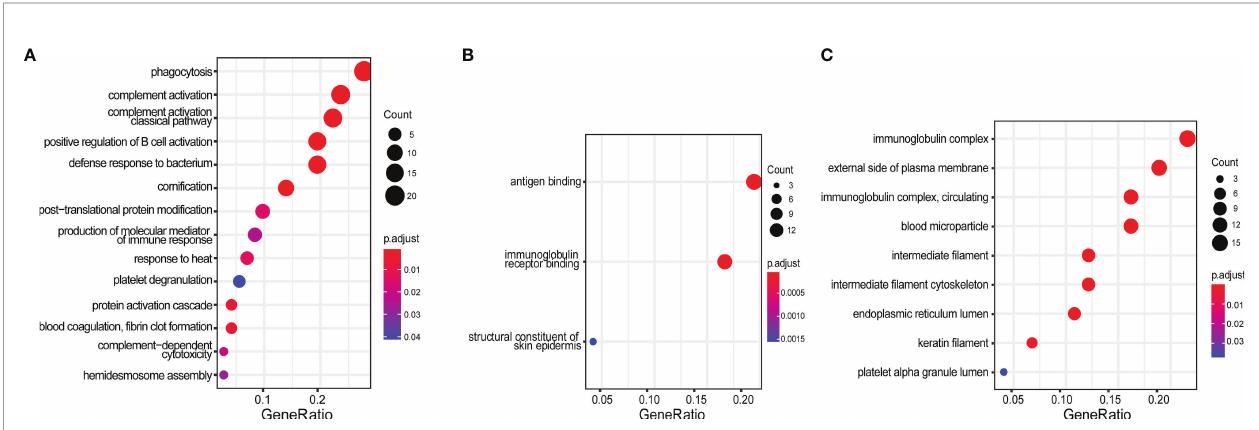
FIGURE 2 | Gene Ontology (GO) enrichment analysis of 77 protein candidates discovered by immunoproteomics. (A) Biological process, (B) molecular function, and (C) cellular component. The gene ratio was calculated by k/n, where k = the size of the unique genes annotated in the speci fi c gene set (e.g., immune complex); n = size of the input genes of interest (e.g., all 77 protein-encoding genes identi fi ed from this study).